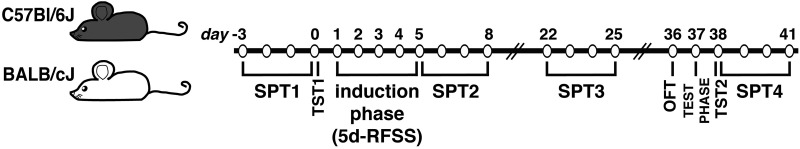
5d-RFSS paradigm. Experimental timeline of 5d-RFSS in C57BL/6J or BALB/cJ mice. SPT1 and TST1 were performed on days −3 to 0, before stressed mice underwent 10 min of forced-swim stress during 5 consecutive days (days 1–5; induction phase), followed by SPT2 (days 5–8), SPT3 (days 22–25), an OFT (day 36), the last forced swim session (test phase; day 37), TST2 (day 38), and SPT4 (days 38–41). Nonstressed controls were not forced to swim during the induction phase but otherwise underwent the same protocol.